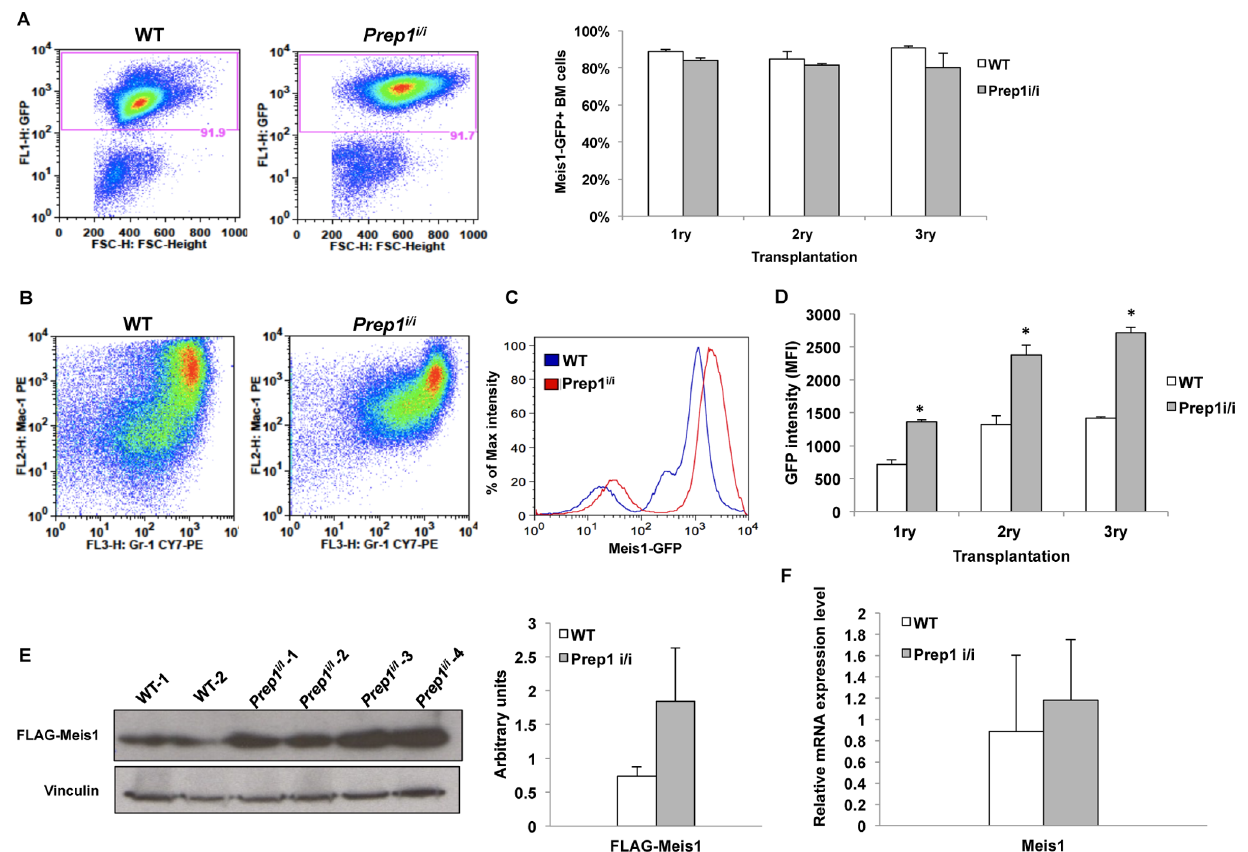
Figure 2. Meis1 expression is higher in Prep1 i/i leukemic cells compared to WT. ( A ) FACS plot represent the Meis1-GFP-positive cells percent in WT and Prep1 i/i leukemic BM cells (left side). Bar graph shows the summary of Meis1-GFP-positive Prep1 i/i and WT BM cells taken from serially transplanted leukemic mice (right side). Error bars indicate SEM. ( B ) FACS plots represent the Mac-1 and Gr-1 positive cells on GFP-positive cell populations from WT and Prep1 i/i leukemic BM. ( C ) Representative FACS plots of Meis1-GFP expression in Prep1 i/i and WT leukemic BM cells co- transduced with Meis1 -GFP and HoxA9 . ( D ) Meis1 -GFP mean fluorescence intensity of Prep1 i/i and WT BM cells taken from serially transplanted leukemic mice is shown as a graph. *p-value , 0.05. Error bars indicate SEM. ( E ) 30 m g of total lysates of leukemic Prep1 i/i and WT BM cells was analyzed by immunoblotting using anti-FLAG antibody. Vinculin was used as loading control. Densitometric analysis was performed using ImageJ64. ( F ) Bar graph shows Meis1 transcript level measured by real-time PCR in Prep1 i/i and WT leukemic bone marrow cells from serially transplanted mice. Error bars show SD.